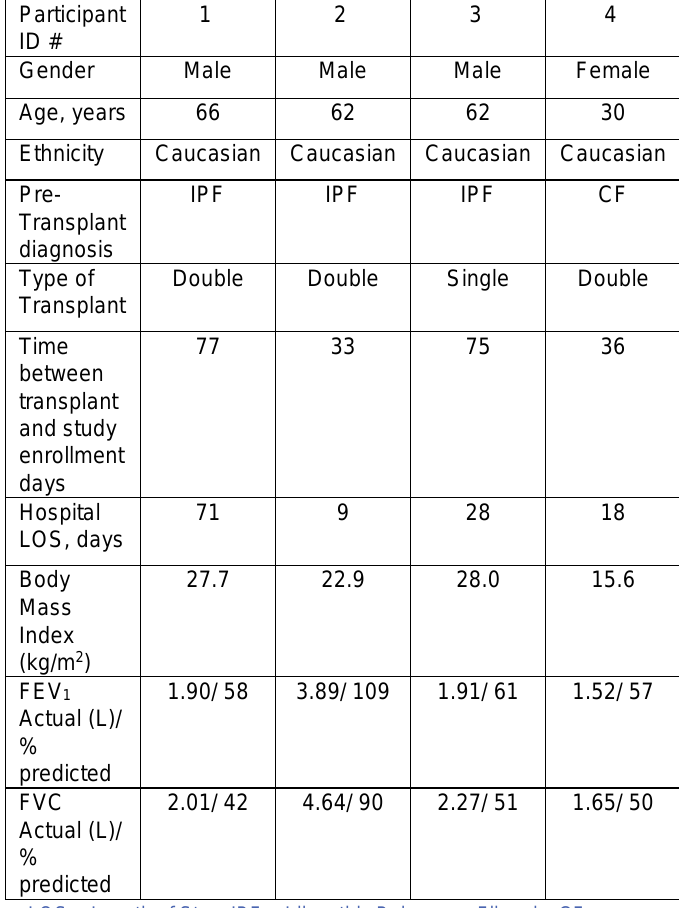
Table 2. Baseline Sample Characteristics